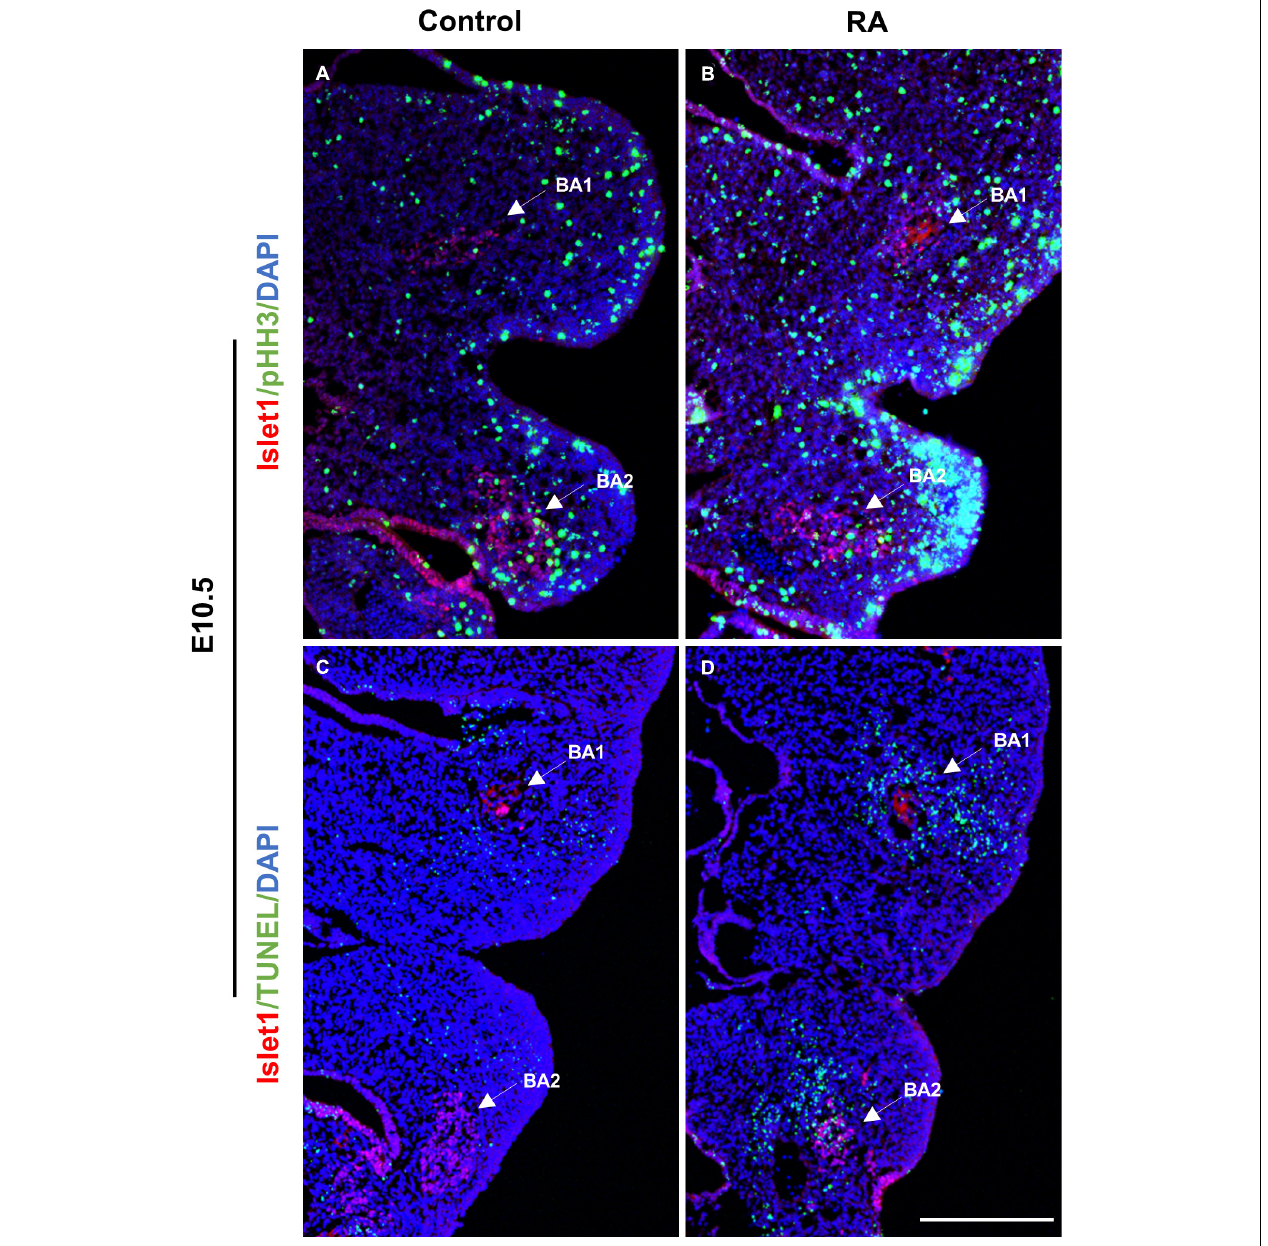
FIGURE 3 | Unaltered proliferation but increased apoptosis in the muscle progenitor cells of the BA1 and BA2 at E10.5 after RA treatment. Immunofluorescent detection of pHH3 (green; A,B ) and TUNEL (green; C,D ) in transverse sections of control (A,C) and RA-treated (B,D) E10.5 embryos. Arrows indicate Islet1-positive (red) muscle progenitor cells in the BA1 and BA2 regions. Scale bar: 250 µ m.